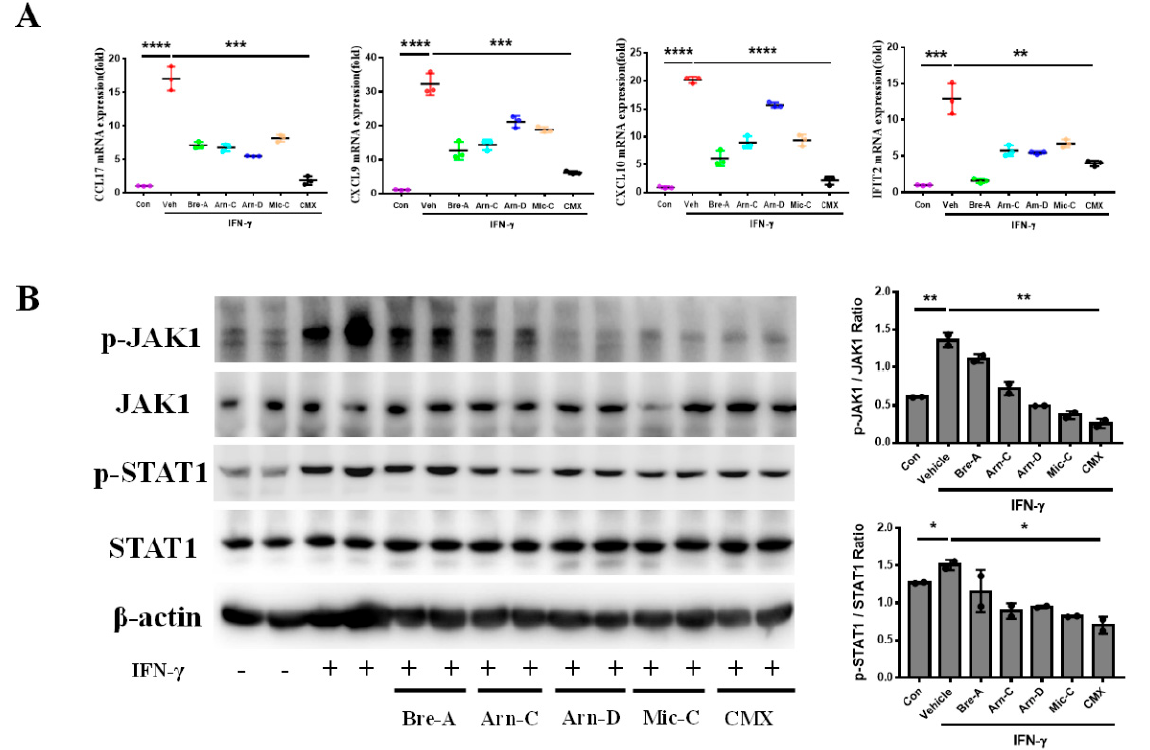
Figure 6. CMX suppresses keratinocytes chemokines production via JAK1-STAT1 pathway induced by IFN- γ . ( A ) The mRNA expression of CCL17, CXCL9, CXCL10, and IFIT2 was detected in HaCaT by RT-qPCR. Relative mRNA expression levels were normalized to mouse GAPDH levels. The data were expressed as means ± sem. * p < 0.05, ** p < 0.01, *** p < 0.001, **** p < 0.0001. Three repeated trials were presented per group ( n ≥ 3). ( B ) Protein expression of p-JAK1, JAK1, p-STAT1, and STAT1 was evaluated by Western blot. Two repeated trials were presented per group ( n = 2). All experiments were repeated 3 times. All concentrations of mixtures or components were 6 µg/mL or 3 µg/mL. Bre-A, Brevilin A; Arn-D, Arnicolide D; Arn-C, Arnicolide C; Mic-C, Microhelenin C; CMX, emulsion extract from Centipeda minima.